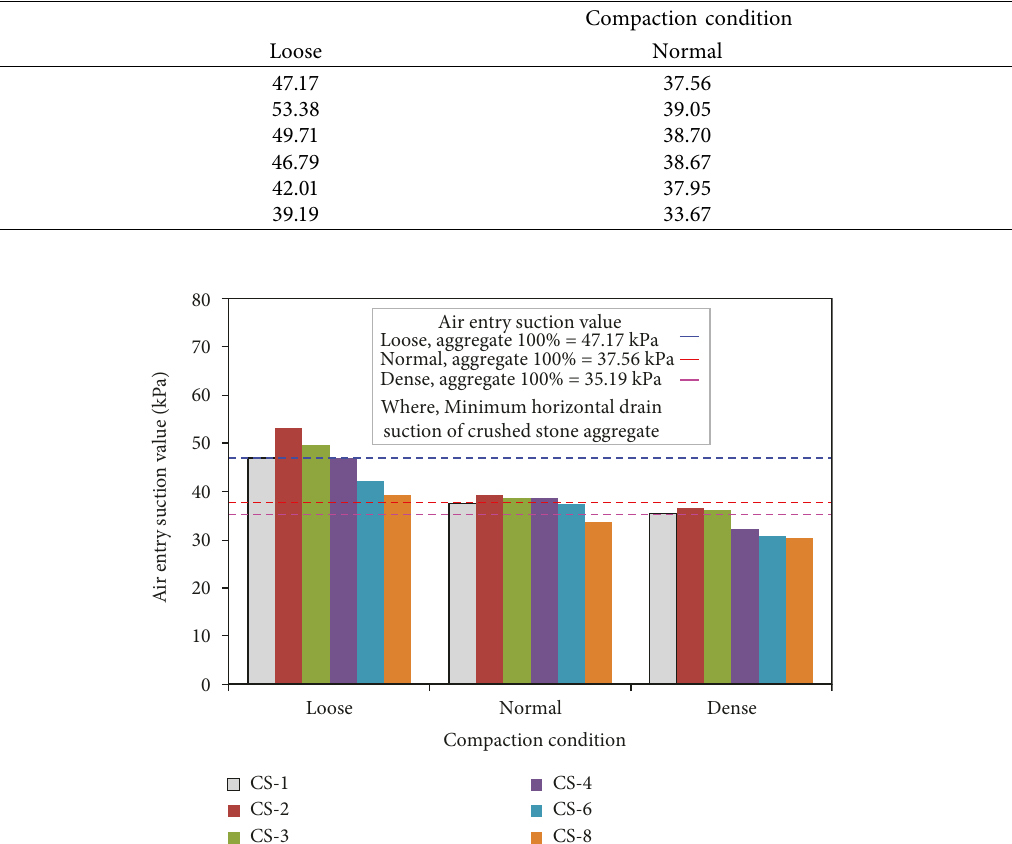
Figure 12: Sample air entry values based on compaction